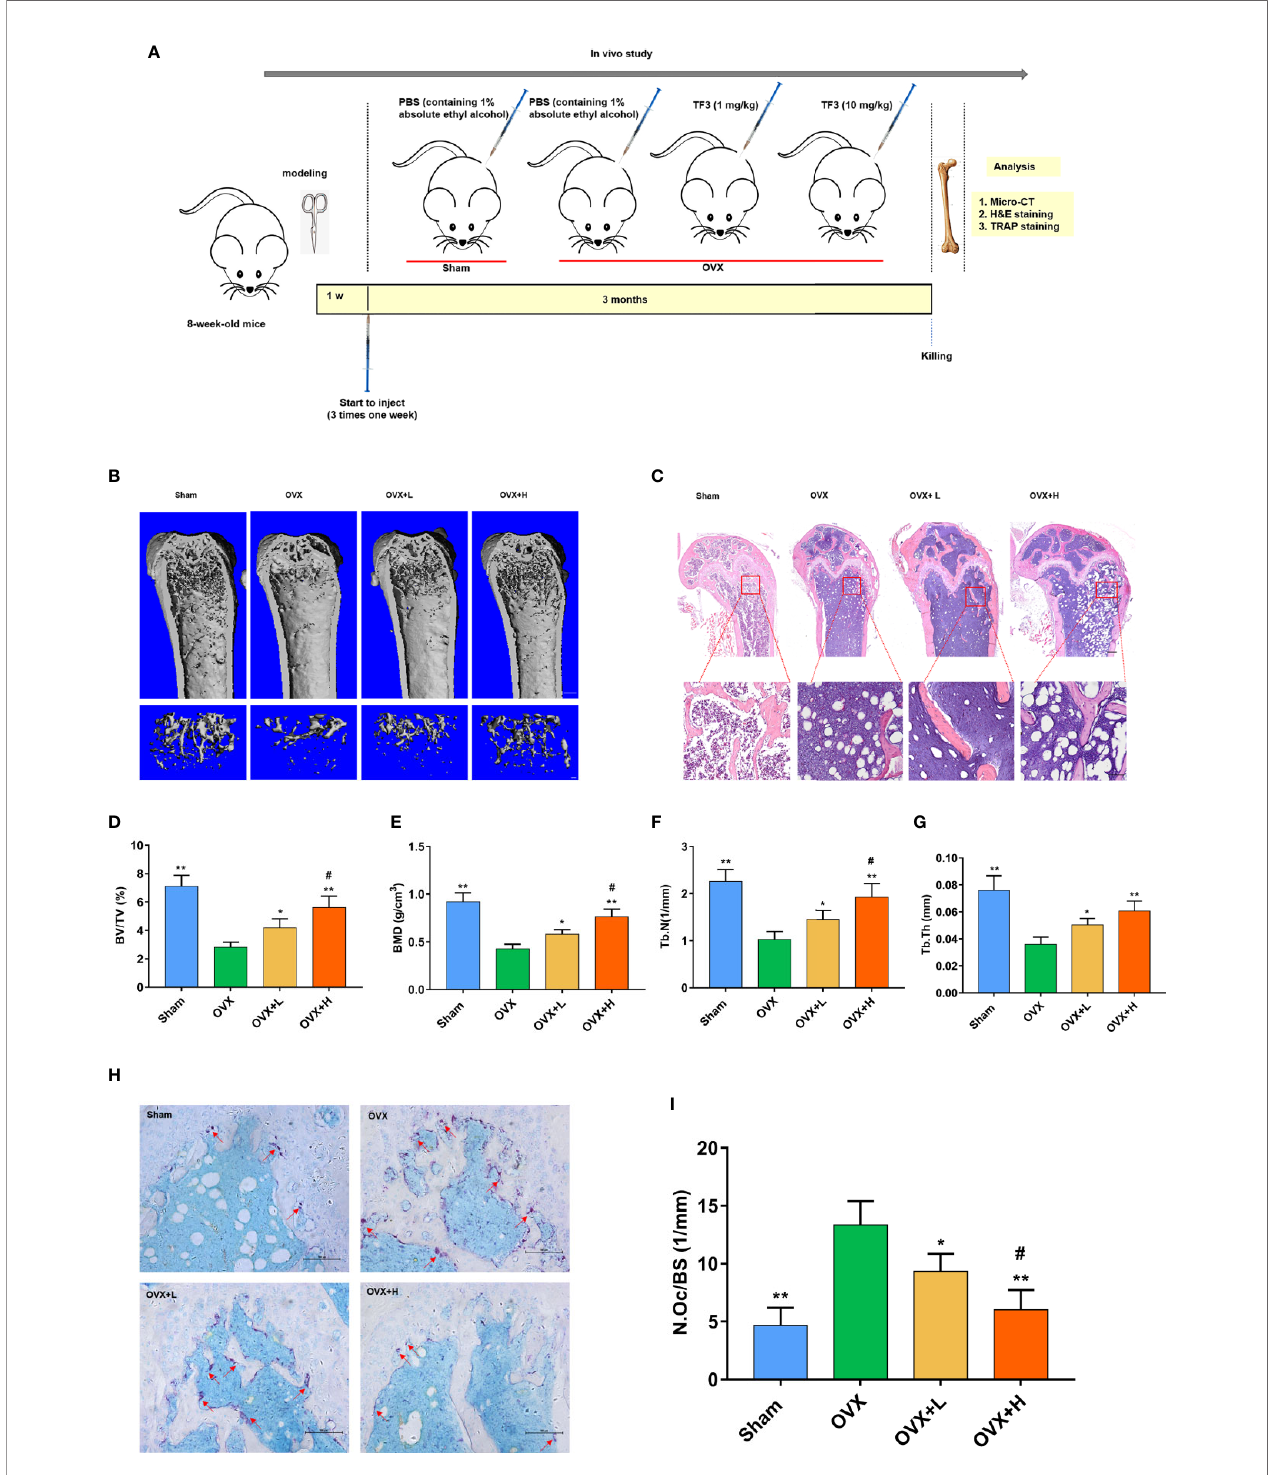
FIGURE 5 | TF3 prevented OVX-induced bone loss and osteoclast formation in vivo . (A) Schematic illustration of the establishment of the OVX mice model and the experimental design. (B) Representative micro-CT images displayed the effects of TF3 on bone loss. Scale bar = 1 mm. (C) Representative images of H&E staining of decalci fi ed bone sections. Scale bar = 100 m m. (D – G) Quantitative analyses of parameters related to bone microstructure, including BV/TV, BMD, Tb.N, and Tb.Th. (H) Representative images of TRAP staining of decalci fi ed bone sections. Scale bar = 100 m m. (I) Quantitative analyses of N.Oc/BS. n = 6, * P < 0.05, ** P < 0.01 compared with OVX group. # P < 0.05 compared with OVX + L